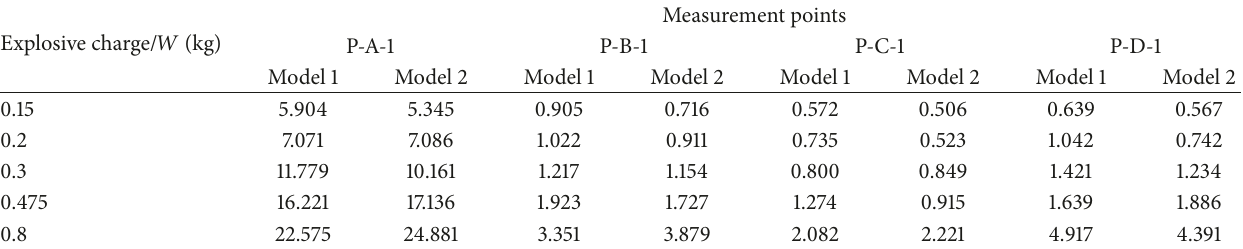
Table 5: The reflected shock overpressure of the internal explosion (MP a ).